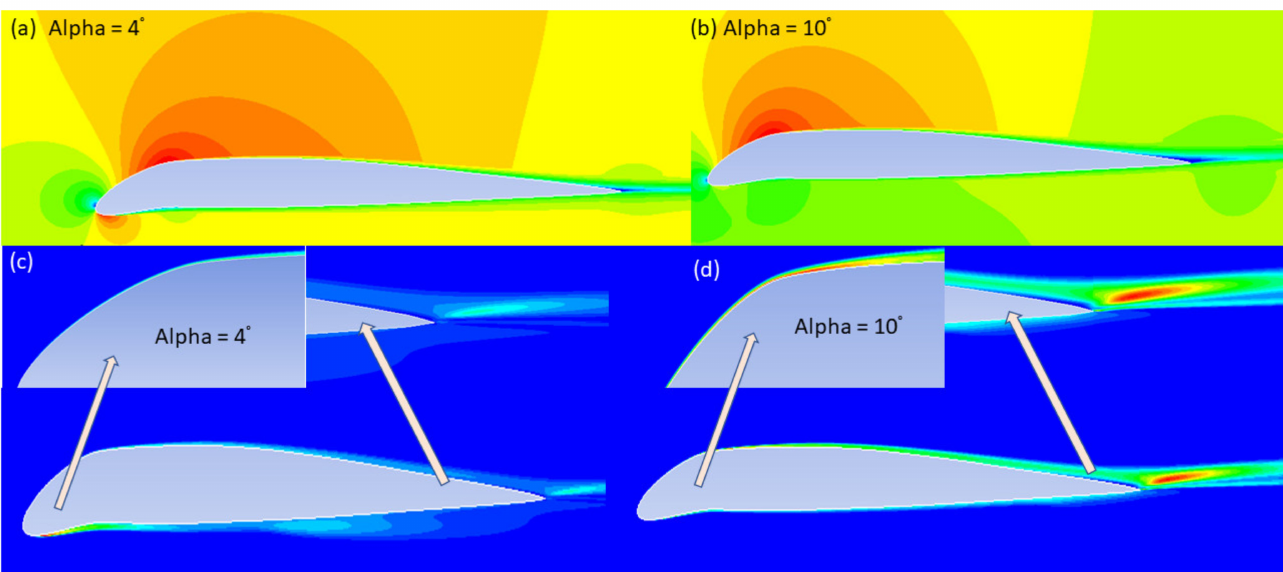
Figure 18. Velocity magnitude and turbulent kinetic energy contour plots. ( a ) Velocity contour lines at low angles of attack such as 4 ◦ ; ( b ) Velocity contour lines at low angles of attack such as 10 ◦ ; ( c ) the turbulent intensity at a low angle of attack of 4 ◦ ; ( d ) the turbulent intensity at a low angle of attack of 10 ◦